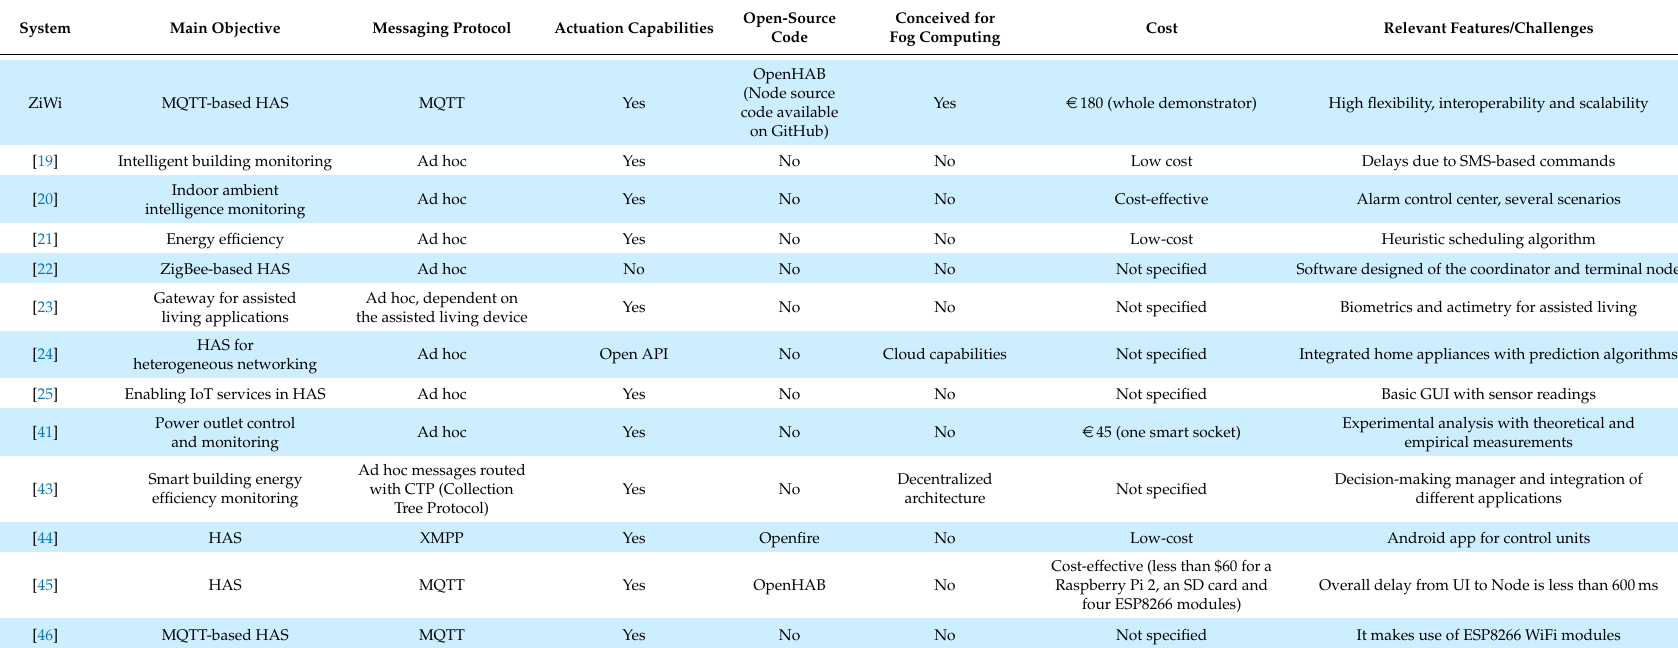
Table 2. Comparison of the main features of the most relevant academic HAS and the proposed system (part